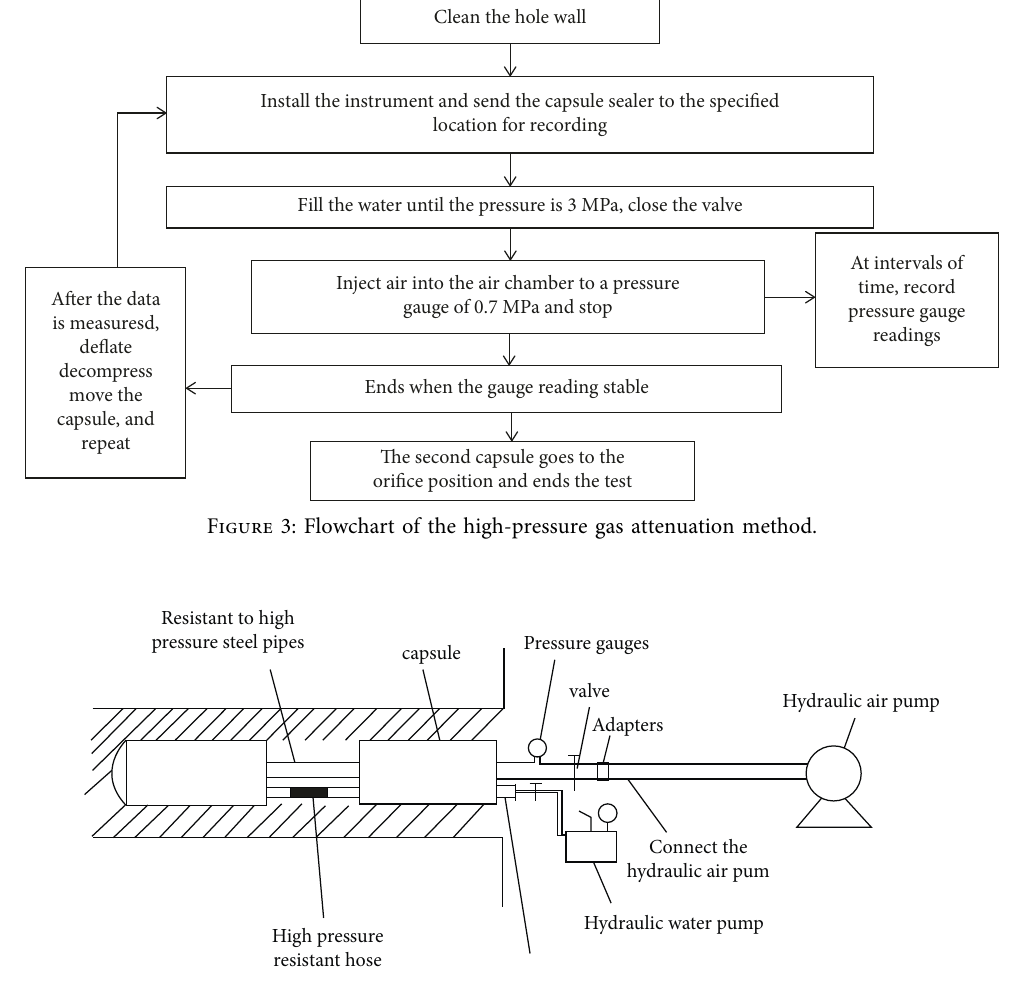
Figure 4: Schematic diagram of the orifice connection